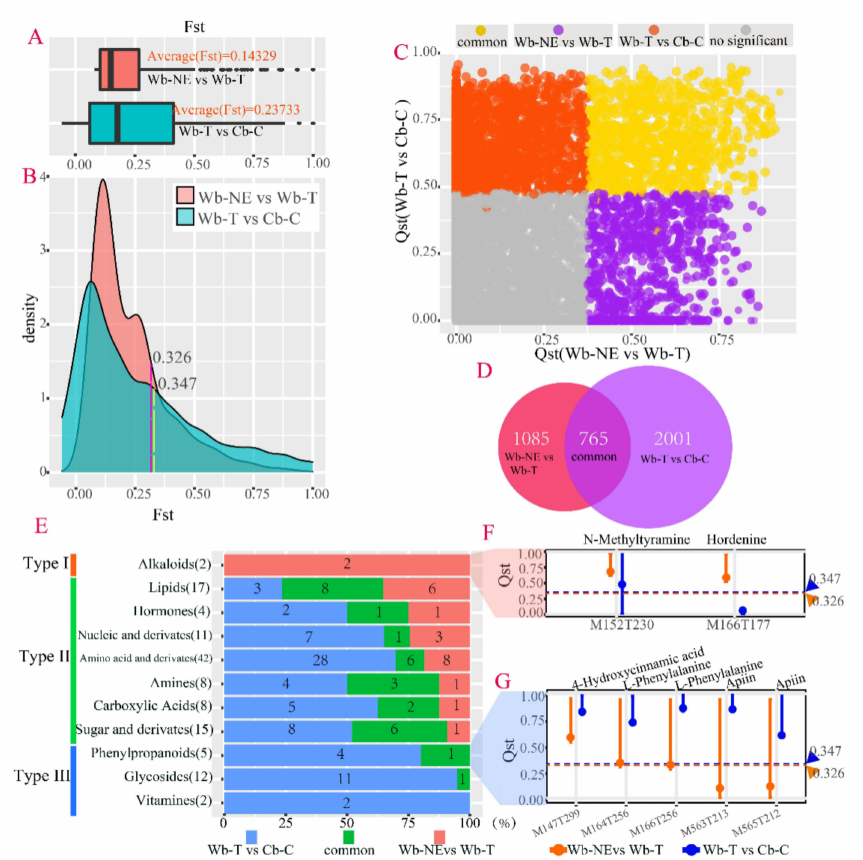
Figure 5. Identification of selective metabolites in barley accessions of Wb-NE vs. Wb-T and Wb-T vs. Cb-C. ( A ) Box plots of Fst in Wb-NE vs. Wb-T and in Wb-T vs. Cb-C. Boxes represented the inter-quartile ranges. The lines across the boxes, the whiskers, and the black circles represent the median values, the 10th, and 90th percentiles and outliers, respectively. ( B ) Density diagrams of Fst in Wb-NE vs. Wb-T and in Wb-T vs. Cb-C. Fst values were higher than 0.326 (the purple dotted line) and higher than 0.347 (the yellow dotted line), indicating that SNPs were under natural or artificial selection in the evolutionary stage from Wb-NE to Wb-T and from Wb-T to Cb-C, respectively. ( C ) Qst distribution associated with Wb-NE vs. Wb-T and Wb-T vs. Cb-C. For each metabolite, Qst was calculated separately for Wb-NE vs. Wb-T and Wb-T vs. Cb-C. The metabolites that exhibited selective status in Wb-NE vs. Wb-T, Wb-T vs. Cb-C, and both are represented by purple circles, red circles, and orange circles, respectively. ( D ) Venn diagram showing the number of selective metabolites in Wb-NE vs. Wb-T, Wb-T vs. Cb-C, and common. ( E ) Different metabolite classes exhibited distinct divergence patterns. The bar chart shows the number of selective metabolites in the corresponding evolutionary process. ( F , G ) Illustration of the divergent pattern using alkaloids ( F ) and phenylpropanoids ( G ). Bars and dots represent 99% CIs of Qst and observed Qst, respectively. Red bars with above 0.326 indicate that corresponding metabolites were selective in Wb-NE vs. Wb-T, and blue bars with above 0.347 indicate that corresponding metabolites were selective in Wb-T vs.